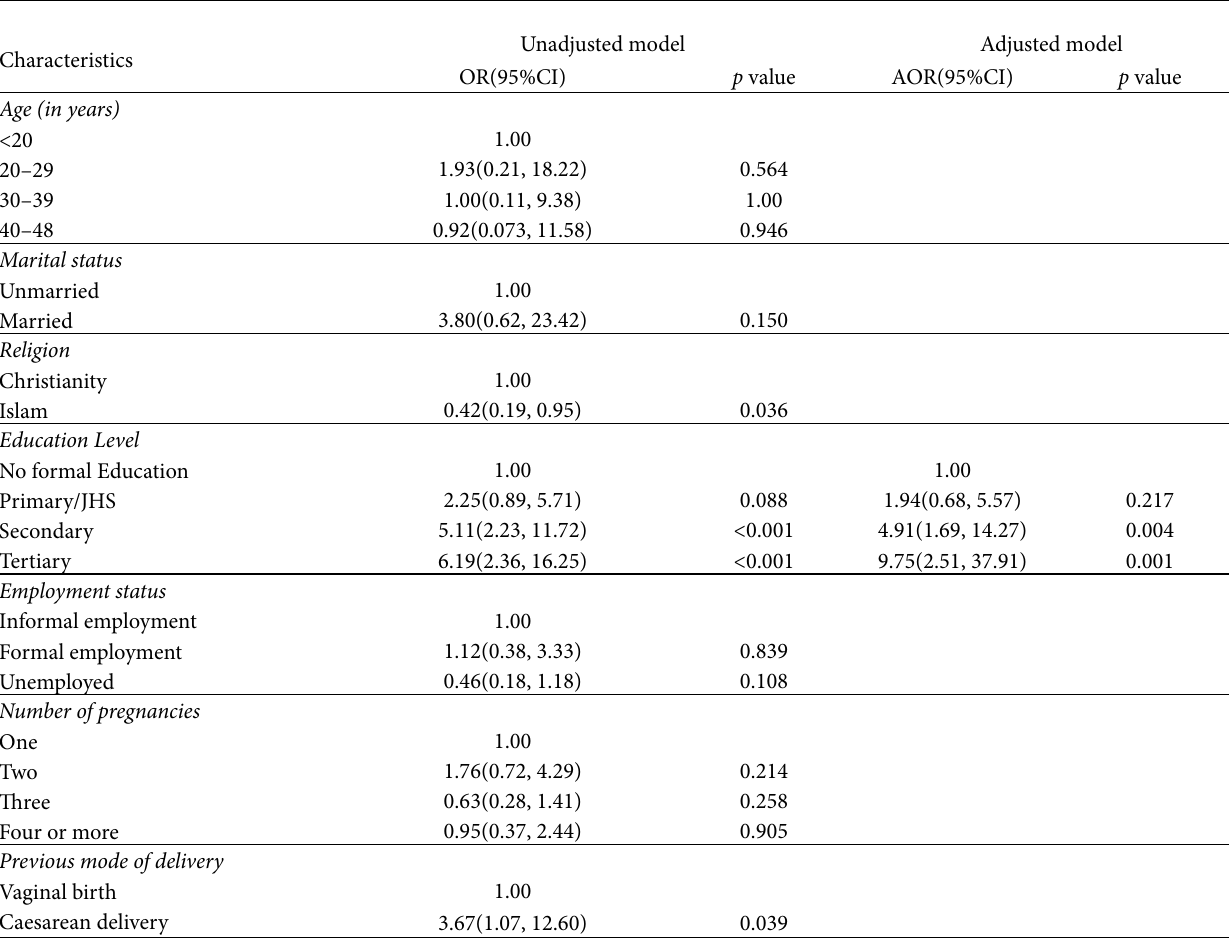
Table 6: Socio‐demographic determinants of women’s perspective about male partner companionship during labour and childbirth.